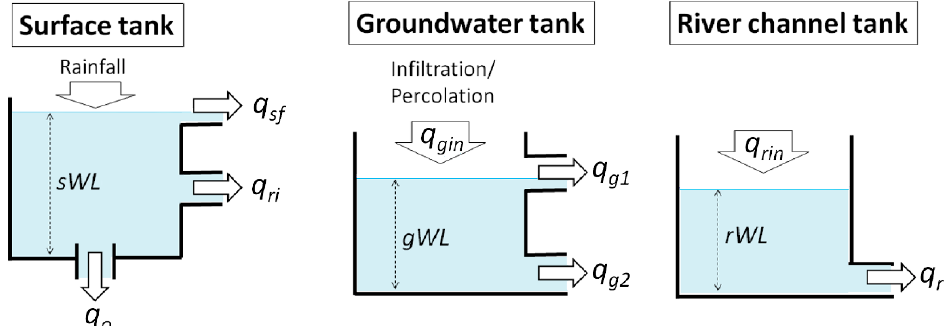
Figure A1. Schematic of the three-tank model in the public works research institute-distributed hydrological model.